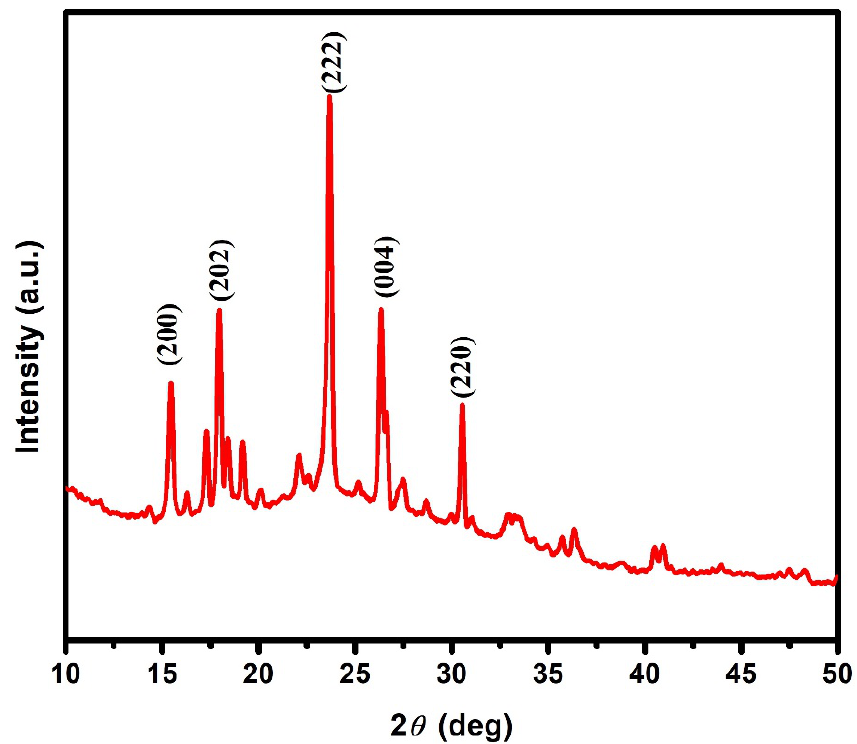
Figure 1. XRD pattern of as-synthesized PNA nanoparticles.